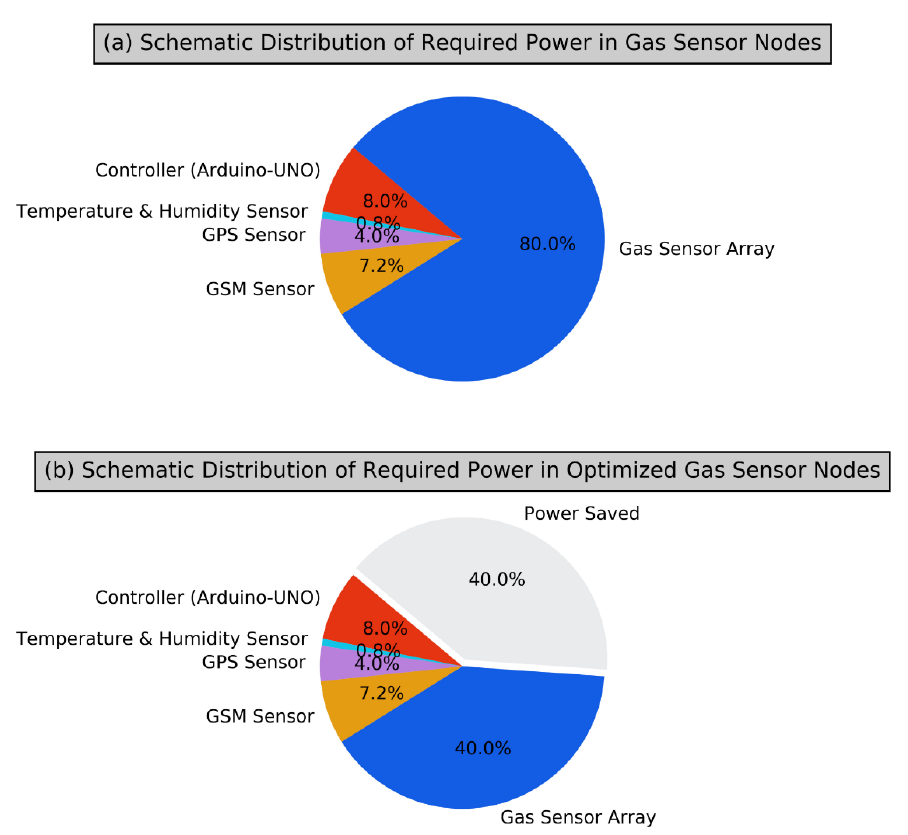
Figure 8. Schematic distribution of required power in gas sensor node; without optimization ( a ); with optimization carried out by our proposed approach ( b ).